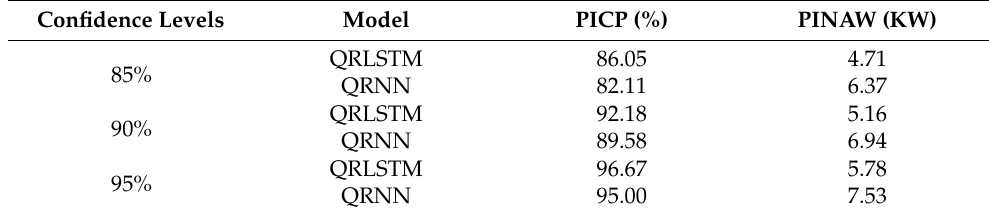
Table 2. Comparison of evaluation indicators on similar-day 2.